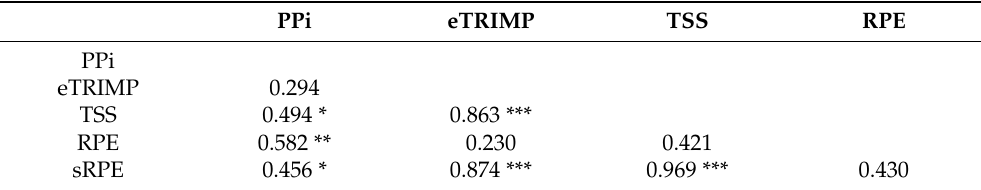
Table 5. Values of Pearson correlation between PPi, eTRIMP, TSS, RPE, and sRPE.